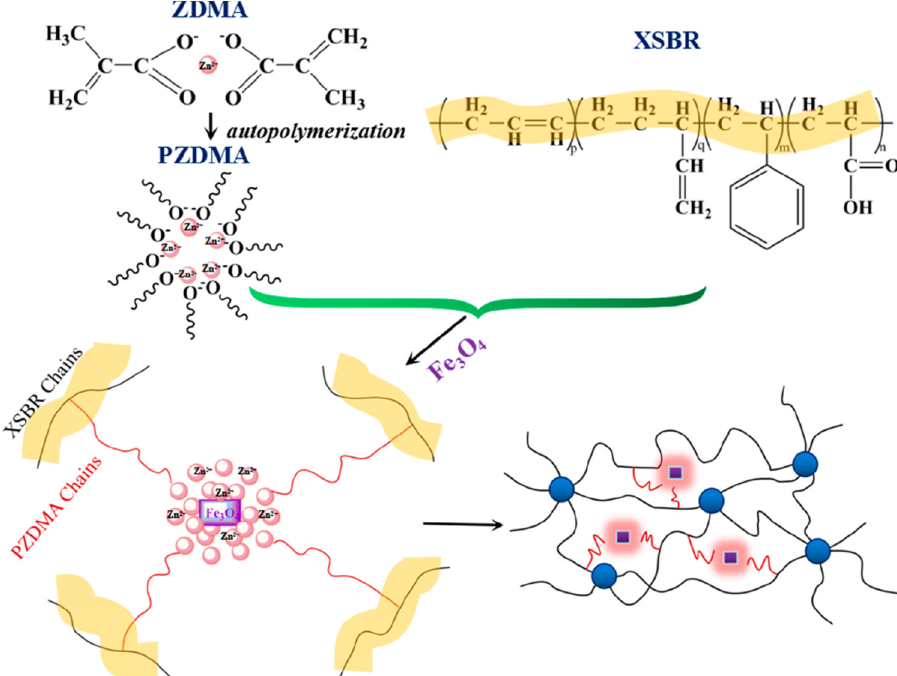
Figure 6. Scheme of the reaction of XSBR, Fe 3 O 4 , and ZDMA (Reproduced with permission from [75], American Chemical Society, 2018).